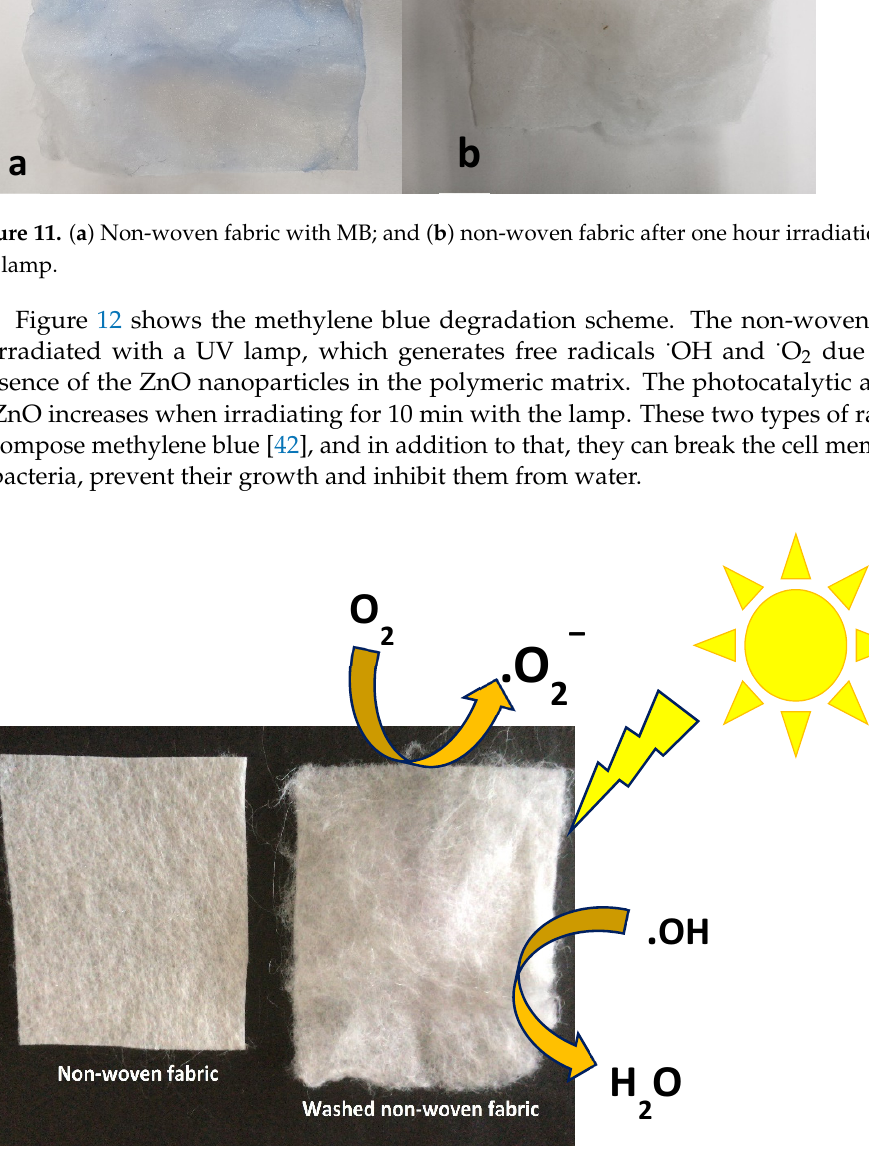
Figure 12. Schematic representations of the degradation mechanism of methylene blue dye on non-woven fabric under UV irradiation.